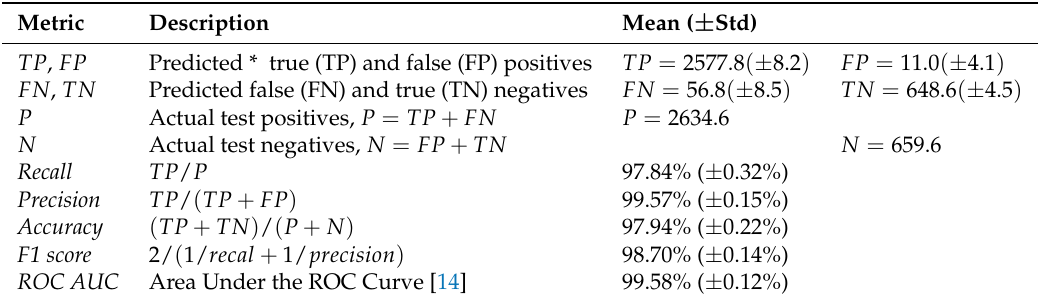
Table 3. Five-fold averaged performance metrics of the final Minke Whale Detector training